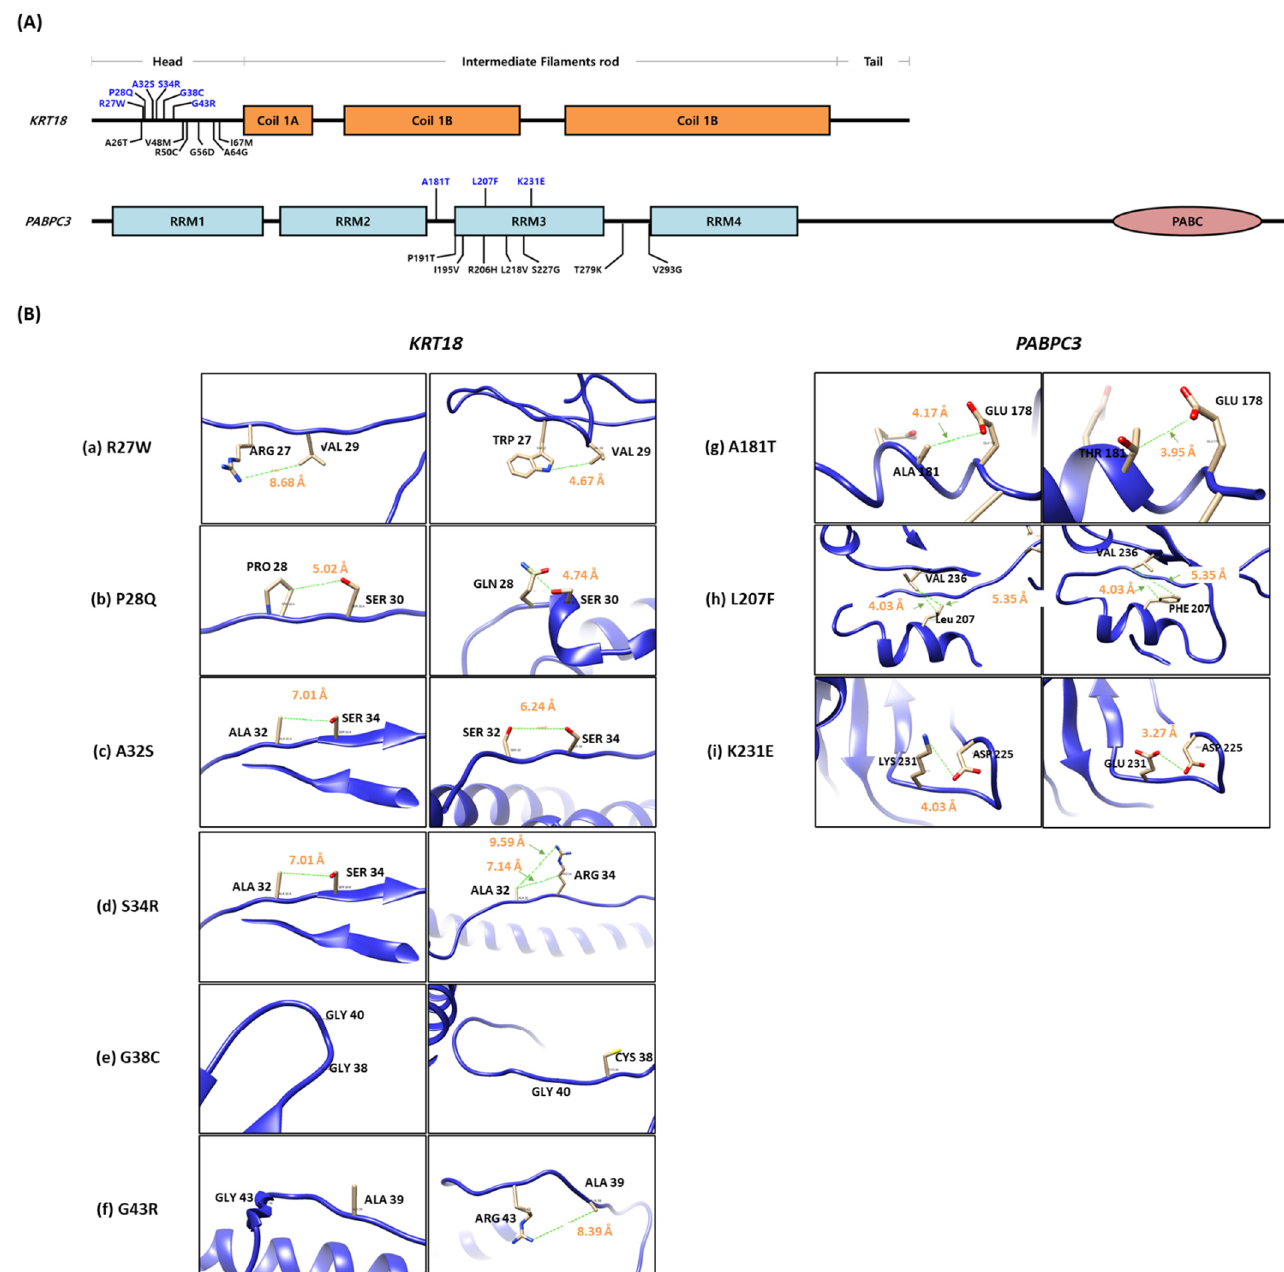
Figure 4. Comparison of the wild-type protein structure with the mutant. ( A ) Gene structures. Blue characters indicate rare variants that have MAF < 0.05. ( B ) Structural comparison of the distance between wild-type (left side) and mutants (right side) in KRT18 ( a – f ) and PABPC3 ( g – i ) protein. The adjacent amino acid is noted by black words, and the predicted distance between two residues in the protein structure is noted by orange words.